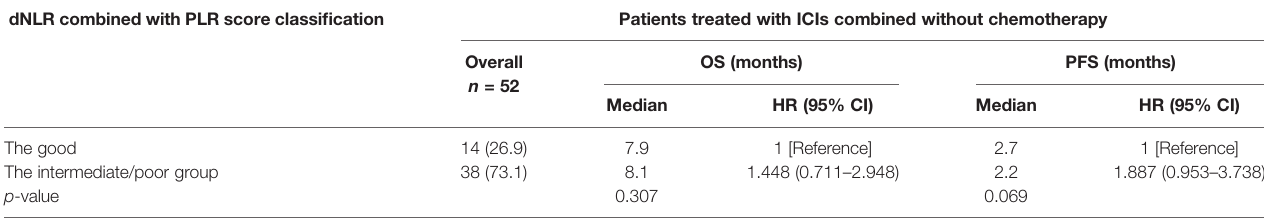
TABLE 10 | Univariate analyses of the good group and the intermediate/poor group associated with OS and PFS of AGC patients treated with ICIs monotherapy. dNLR combined with PLR score classi fi cation